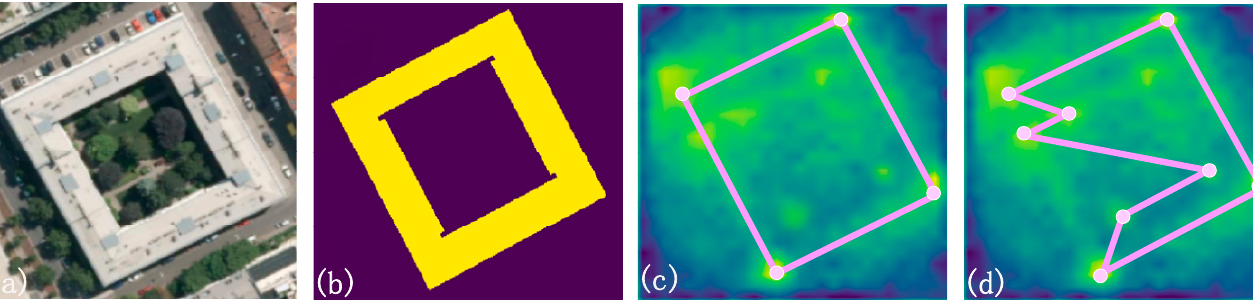
Figure 2. The failed case of Vienna in INRIA datasets: ( a )aerial image; ( b )ground-truth; ( c ) probability map for corner; and ( d ) results of the OEC-RNN.